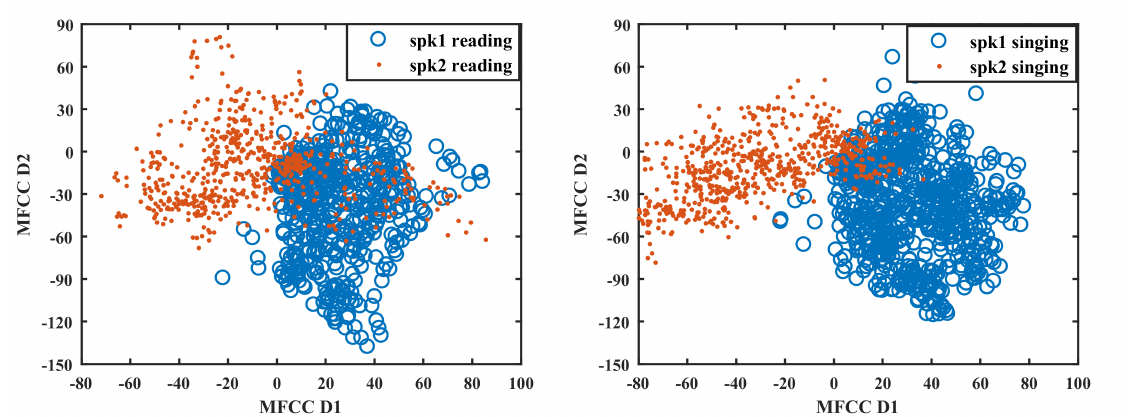
Figure 3. MFCC PCA feature distribution of reading ( left ) and singing ( right ) speech between two females with the same